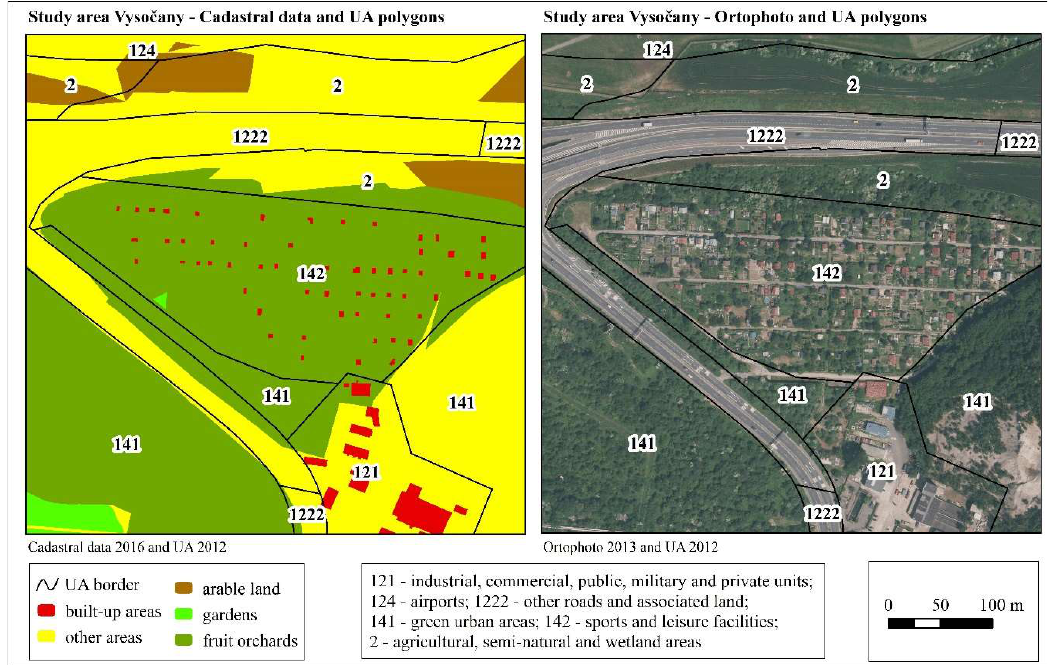
Figure 8. Map of the CU Vysočany. The colours symbolise the KN legend classes: red 13, yellow 14, light green 5, green 6, brown 2, black line polygon UA. Source: [32,34,36].